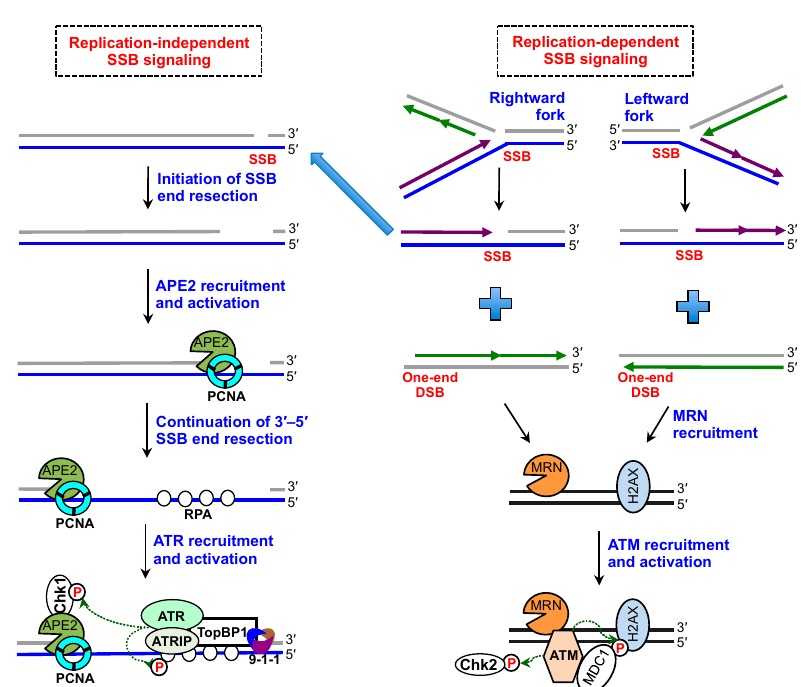
Figure 4. SSB signaling. Left panel demonstrates replication-independent SSB signaling. Following initiation of SSB end resection, APE2 is recruited and activated by PCNA interaction and ssDNA association. SSB end is resected by APE2 in the 3 ′ –5 ′ direction to generate ssDNA for RPA recruitment and assembly of ATR DDR protein complex including ATR, ATRIP, TopBP1, and the 9-1-1 complex. Activated ATR phosphorylates Chk1 and RPA32. Right panel shows replication-dependent SSB signaling. When replication fork (rightward or leftward) meets SSB site, one-end DSB and new SSB are generated. The replication-derived SSB may proceed with 3 ′ –5 ′ SSB end resection and subsequent ATR DDR pathway. The one-end DSB triggers MRN complex recruitment and ATM DDR activation including γ –H2AX and Chk2 phosphorylation.